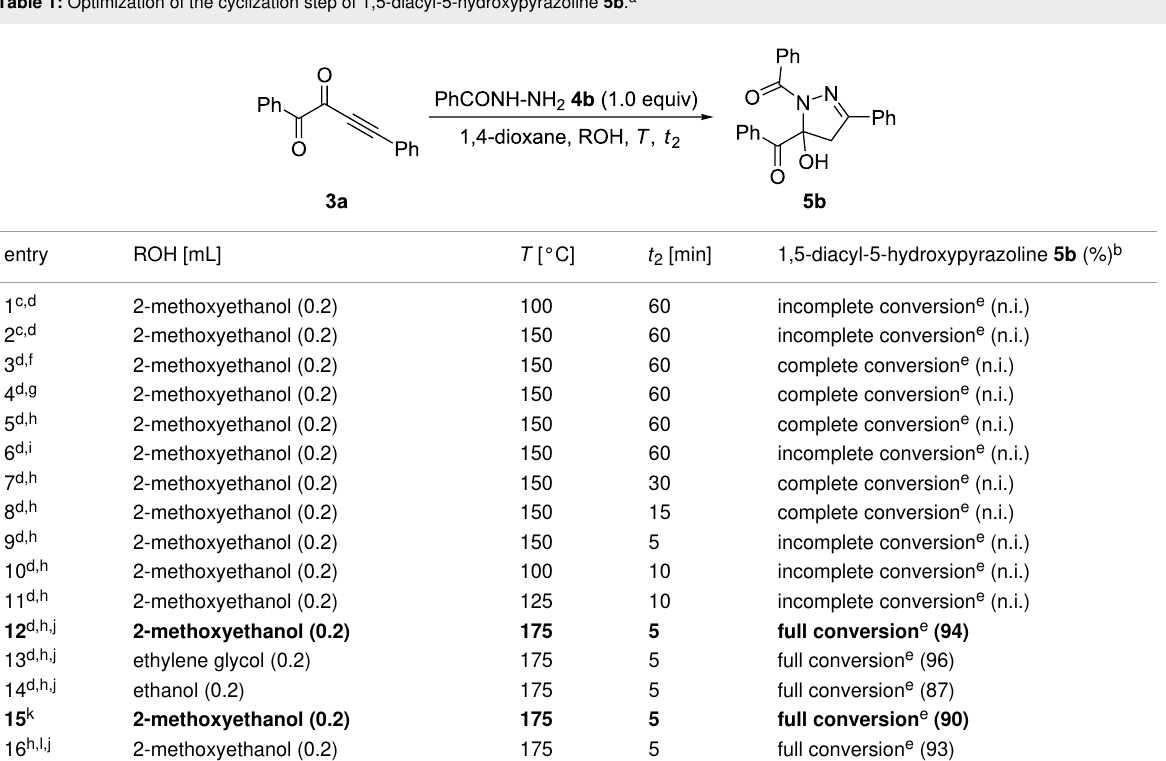
Table 1: Optimization of the cyclization step of 1,5-diacyl-5-hydroxypyrazoline 5b . a